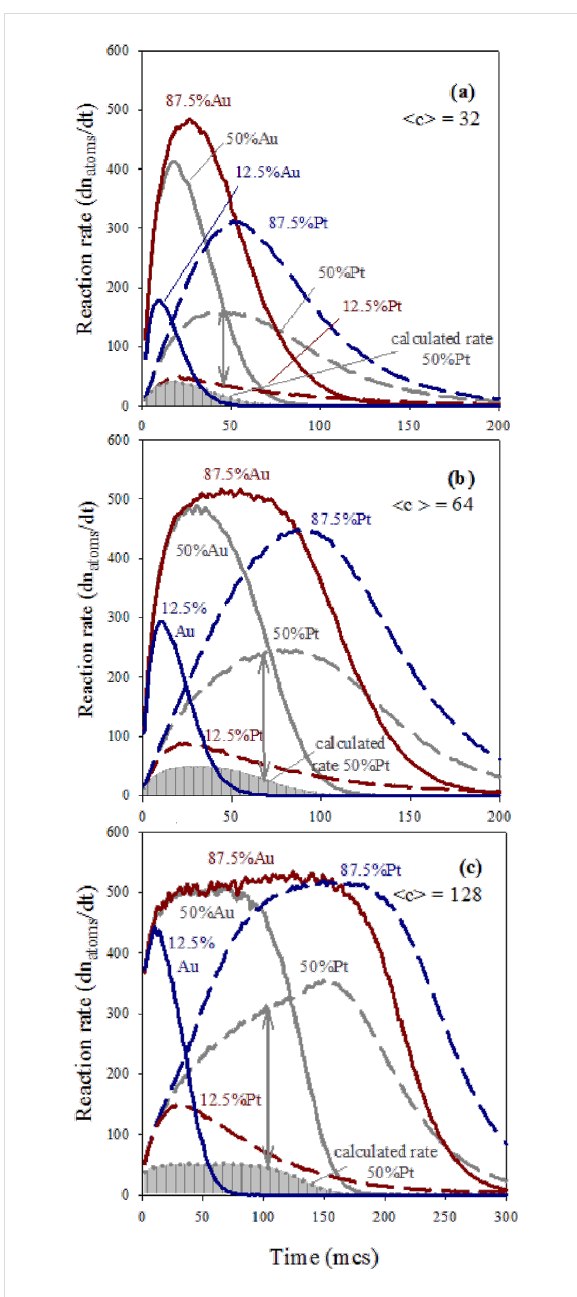
Figure 5: Reaction rate versus time. Continuous and discontinuous lines show the resulting Au and Pt, respectively. Synthesis conditions: flexible film ( k ex = 5, f = 30), reduction rate ratio v Au /v Pt = 10. Scheme color: dark blue lines: 12.5% Au, grey lines: 50% Au, dark red lines: 87.5% Au. Curves delimiting grey areas shows the calculated Pt rate as 0.10 times the Au reaction rate: v Pt,calculated = 0.10 ∙ dn Au /dt. a) average